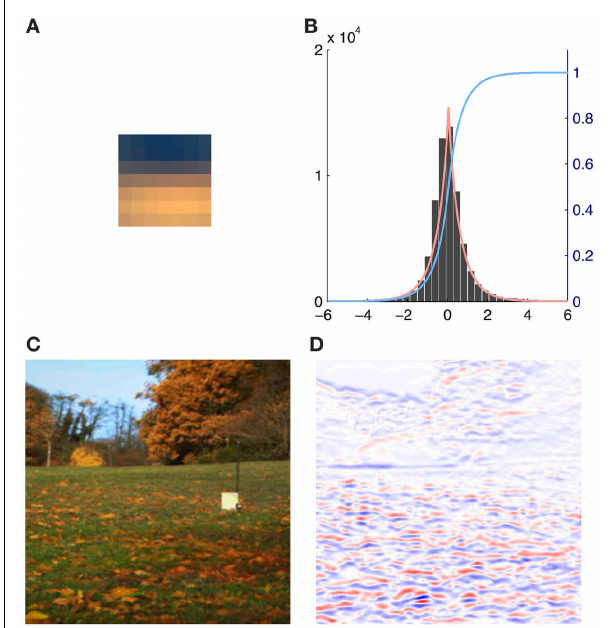
FIGURE 2 | Illustration of the contribution of a single basis function (number 116) to an image together with the exponential power distribution fit of the corresponding source activations. (A) Activation triggered average of basis function 116. (B) Histogram of the source coefficient values showing a typical leptokurtic distribution with a peak around zero and heavy tails. The fit of the exponential power distribution to the data ( β : 1.312, μ : 0.001, σ : 0.753) is shown in red and the cumulative distribution function F ( x ) is plotted in blue. (C) RGB rendering of the original image. (D) Contributions to the image, red indicates high positive, blue high negative and white no contributions of basis function